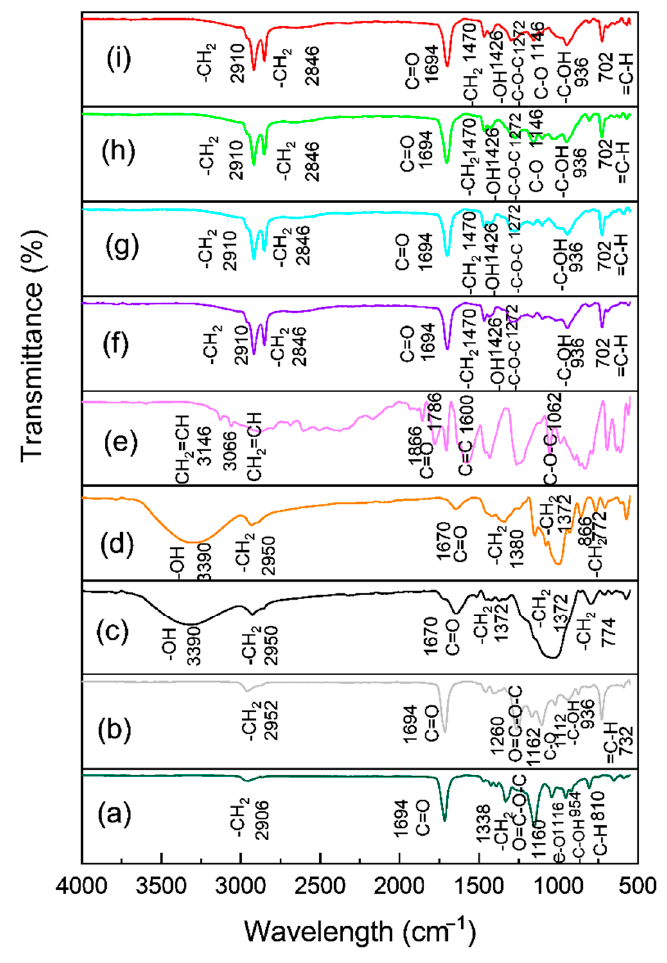
Figure 1. FT-IR spectra of the PBS/PBAT/TPS composites and PBS/PBAT/TPRH composites ( a ) PBS, ( b ) PBAT, ( c ) rice husk, ( d ) starch, ( e ) maleic anhydride, ( f ) TPRH48/12, ( g ) TPS48/12, ( h ) TPRH36/24, and ( i ) TPS36/24.